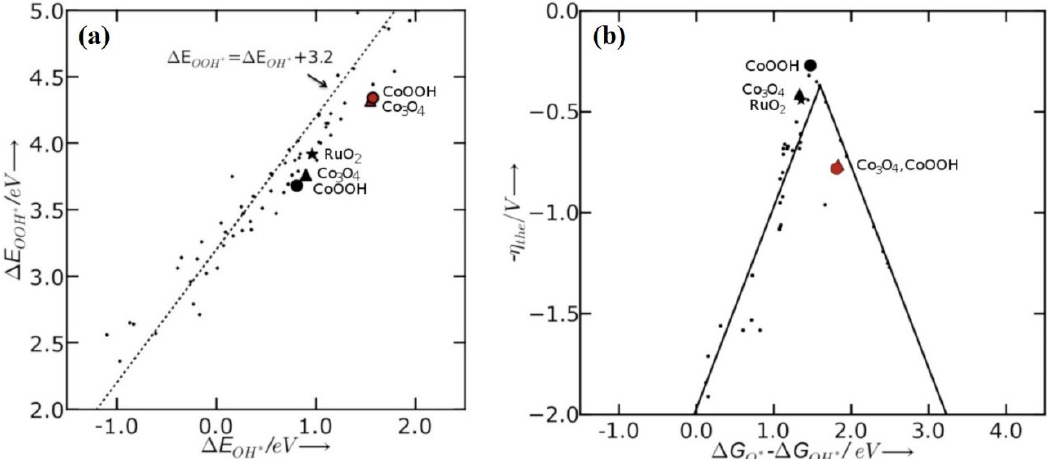
Figure 33. ( a ) Adsorption energies of OOH* (Δ E OOH* ) as a function of the adsorption energies of OH* (Δ E OH* ) on the oxygen-covered Co 3 O 4 (001) and CoOOH (011 ̅ 2) surfaces, shown in triangles and circles, respectively. The black and red colors correspond to the calculations performed with RPBE and with RPBE+ U , respectively. The small black circles correspond to Δ E OOH* as a function of Δ E OH* on the oxide surfaces. The black star indicates the position of RuO 2 (110). The binding energies of OOH* and OH* scale according to the relation, Δ E OOH* = Δ E OH* + 3.2, with 95% of the points being within ±0.4 eV. ( b ) Calculated theoretical overpotentials (η the ) plotted as a function of (Δ G O* − Δ G OH* ) for oxygen-covered Co x O y surfaces. The small black circles correspond to η the as a function of (Δ G O* − Δ G OH* ) on rutiles and perovskites. The volcano curve is established by using the scaling relation between (Δ G OOH* − Δ G O* ) and (Δ G O* − Δ G OH* ). (Reprinted from ref. [170] with permission from The Journal of Physical Chemistry C © 2012, American Chemical Society).